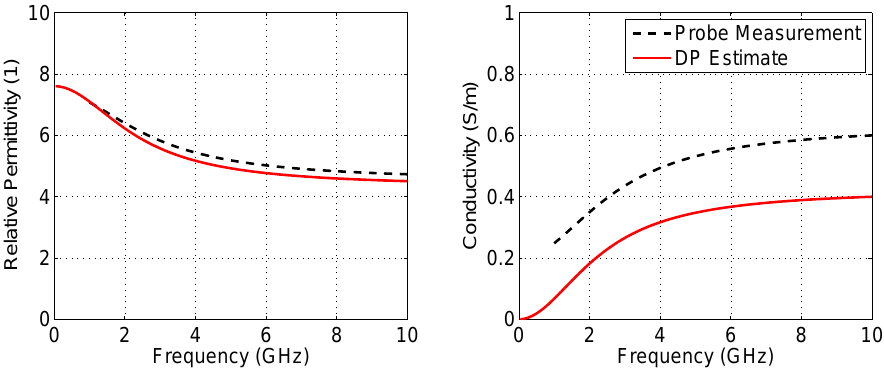
Figure 11. Estimated average DPs for glycerin using measured results.